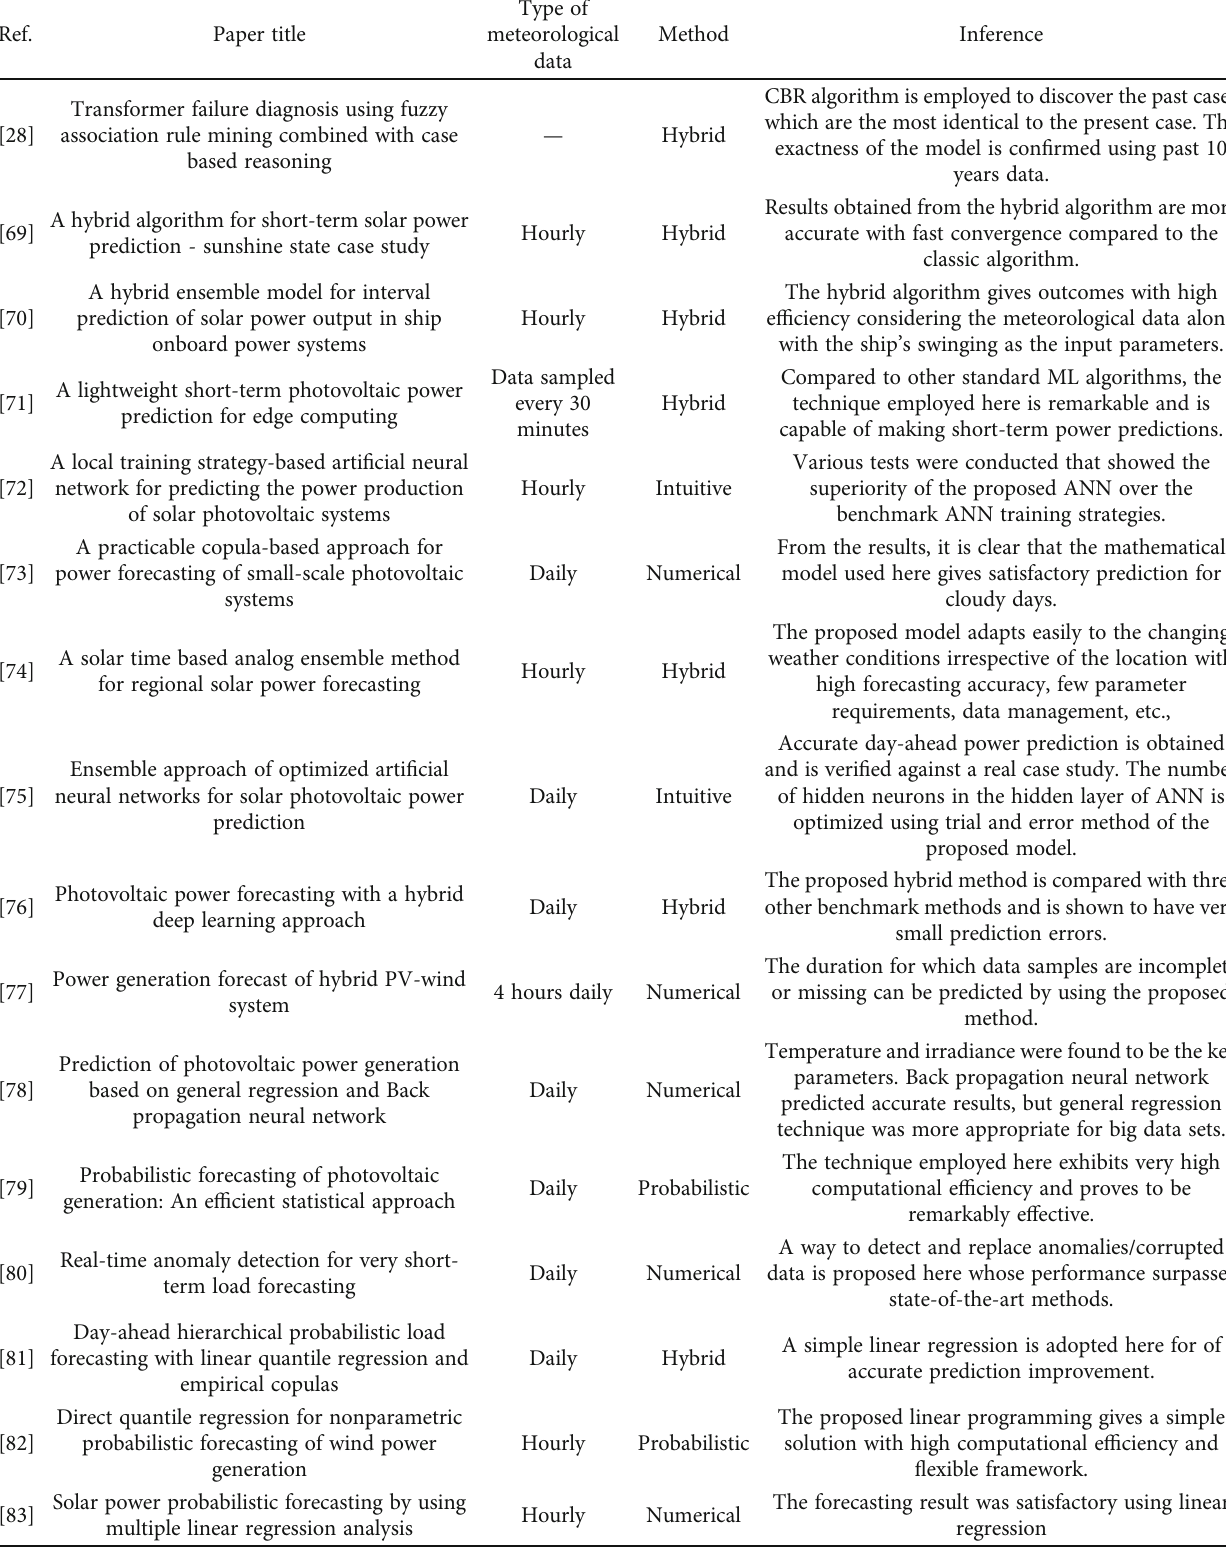
Table 7: Methods of analysing meteorological